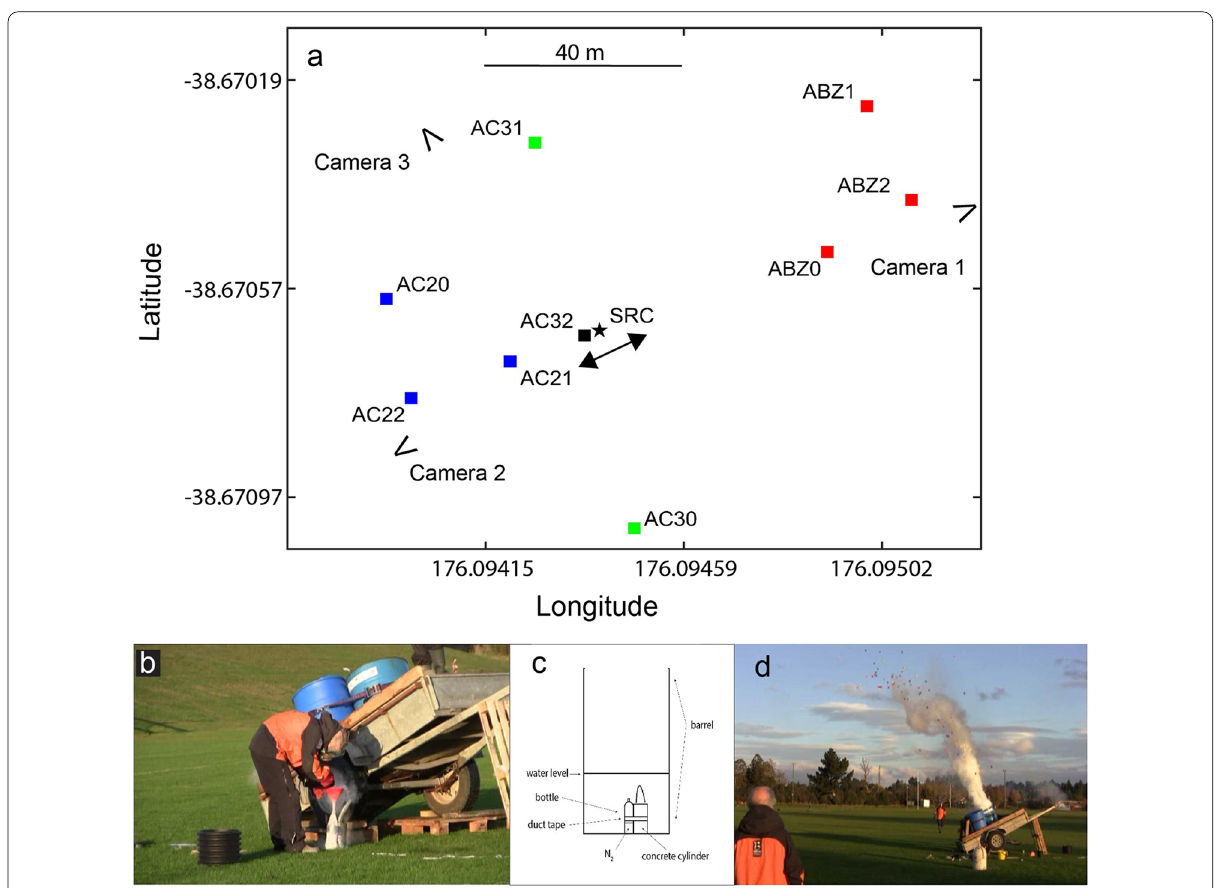
Fig. 1 Map ( a ) showing experimental setup and distribution of sensors (squares colored red for northeast sensors, blue for southwest sensors, green for sensors lateral to the discharge direction and black for a sensor under the cannon). The angled blast direction is shown by the black double arrow. Latitude and longitude are given in decimal degrees. Cameras (V open to the look direction) documented 10 successful discharges. The black star shows the cannon. For each experiment, the bottle ( b ) was partially filled with liquid-nitrogen, sealed with the cap and placed in the partially water filled barrel (see “Experimental setup” section). Diagram showing the discharge apparatus within the barrel shown in c . An example discharge ( d ) for Experiment 11 yielded a lateral discharge of a water/nitrogen mixture. Colored balls aided assessment of discharge exit velocities. Images ( b , c ) are from video captures generated by Julian Thompson (GNS